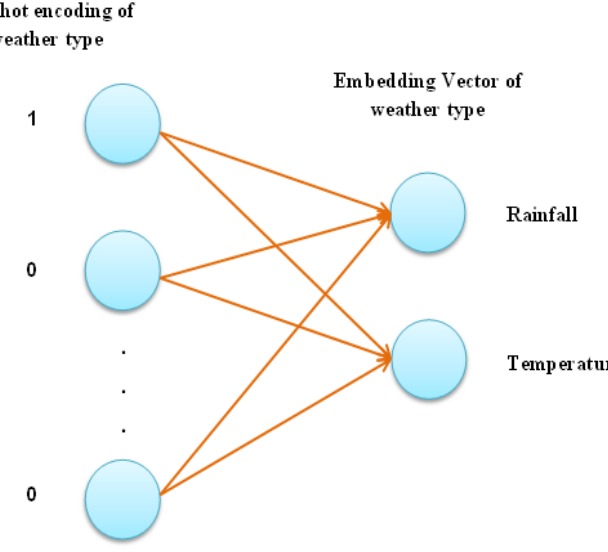
Figure 5. Relationship between one hot encoding and embedding